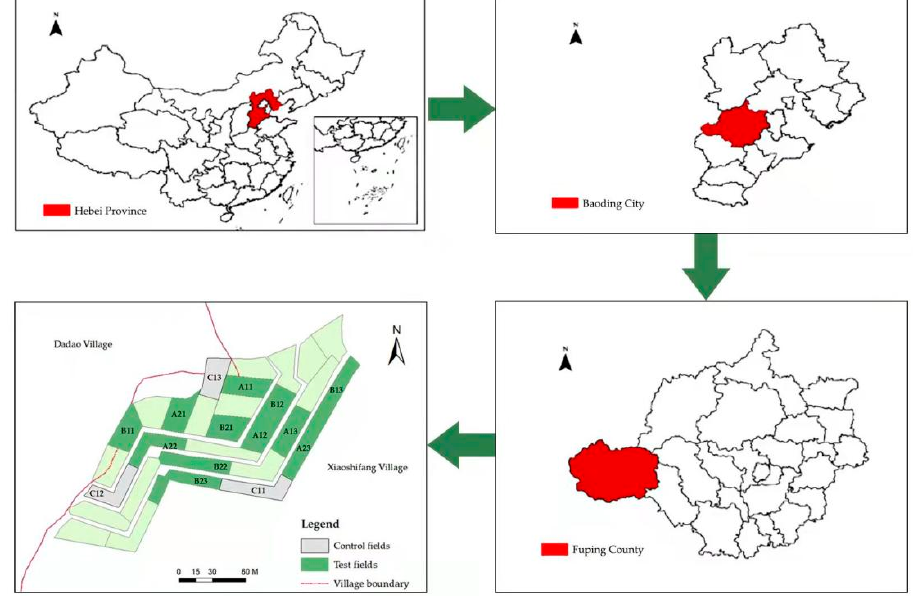
Figure 1. Location of the study area.